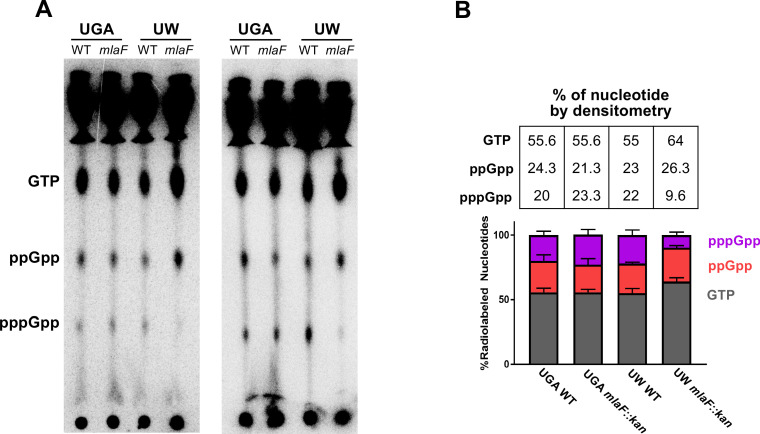
Nucleotide profile of UGA and UW strains.(A) Additional replicates of TLC separation of radiolabeled nucleotides as described in Figure 5. Relative positions of pppGpp, ppGpp, and GTP are labeled. (B) Densitometry quantification of pppGpp, ppGpp, and GTP spots. Relative percentages were calculated within a given genotype. Error bars are standard deviation of three replicates. Distributions are visualized by bar chart and colored by nucleotide species. Average percentages of three biological replicates are displayed in the table.